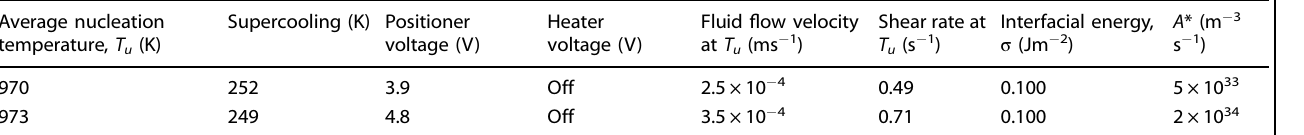
Table 2. Experimental data for Cu 50 Zr 50